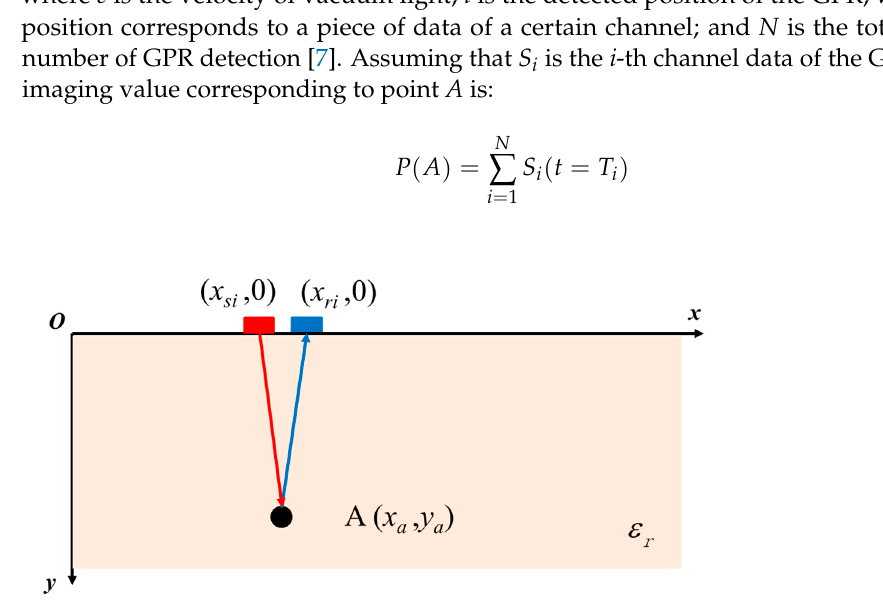
Figure 1. The schematic diagram of back projection algorithm. The red rectangle is the transmitting antenna and the blue rectangle is the receiving antenna. The black circular is the target object. Point A is a generic point in the detection region. The x-axis is the measuring line, and the y-axis is the detection depth. The background dielectric constant is ε r [13].